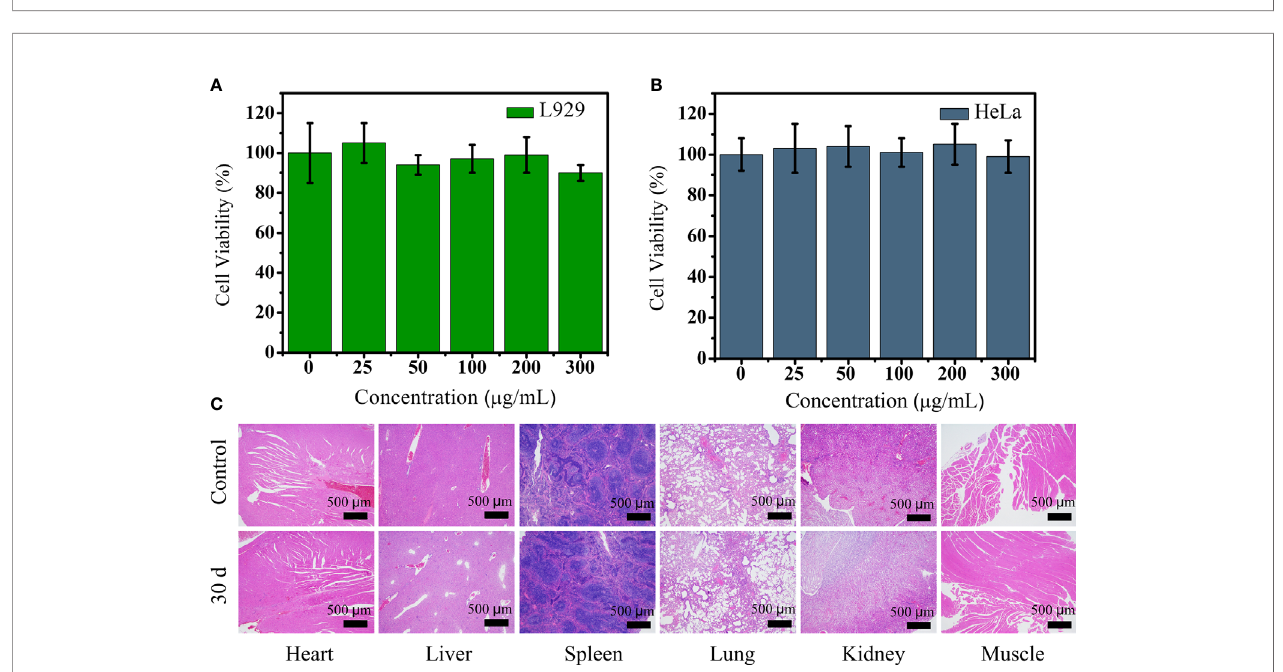
FIGURE 3 | (A, B) Viability of L929 and HeLa cells after incubation with different concentrations of PEG-HoF 3 NPs; (C) Tissue sections of 6 major organs from mouse which injected with PEG-HoF 3 NPs via tail